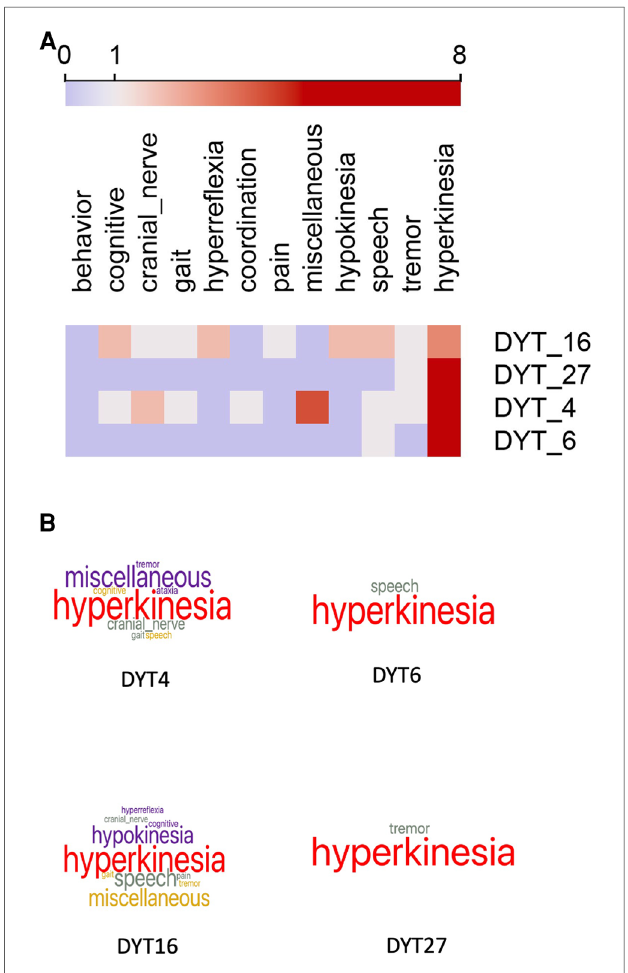
FIGURE 3 ( A ) Heat map of four selected cases of dystonia. Columns are feature superclasses, and rows are diseases. heat maps and word clouds are based on Table 1 . Each row in the heat map represents a column of signs and symptoms from Table 1 . Feature scores range from 0 to 8, with the color scale centered at 1. Word cloud visualizations of each row are below. Compare to Table 1 for comprehensibility. ( B ) Word clouds for the four forms of dystonia represented in the heat maps above and Table 1 . Word size re fl ects the feature count in each superclass. DYT6 and DYT27 are pure dystonia, whereas DYT4 and DYT16 have other non-dystonic features. Compare to Table 1 for comprehensibility. Underlying data available in Supplementary Materials